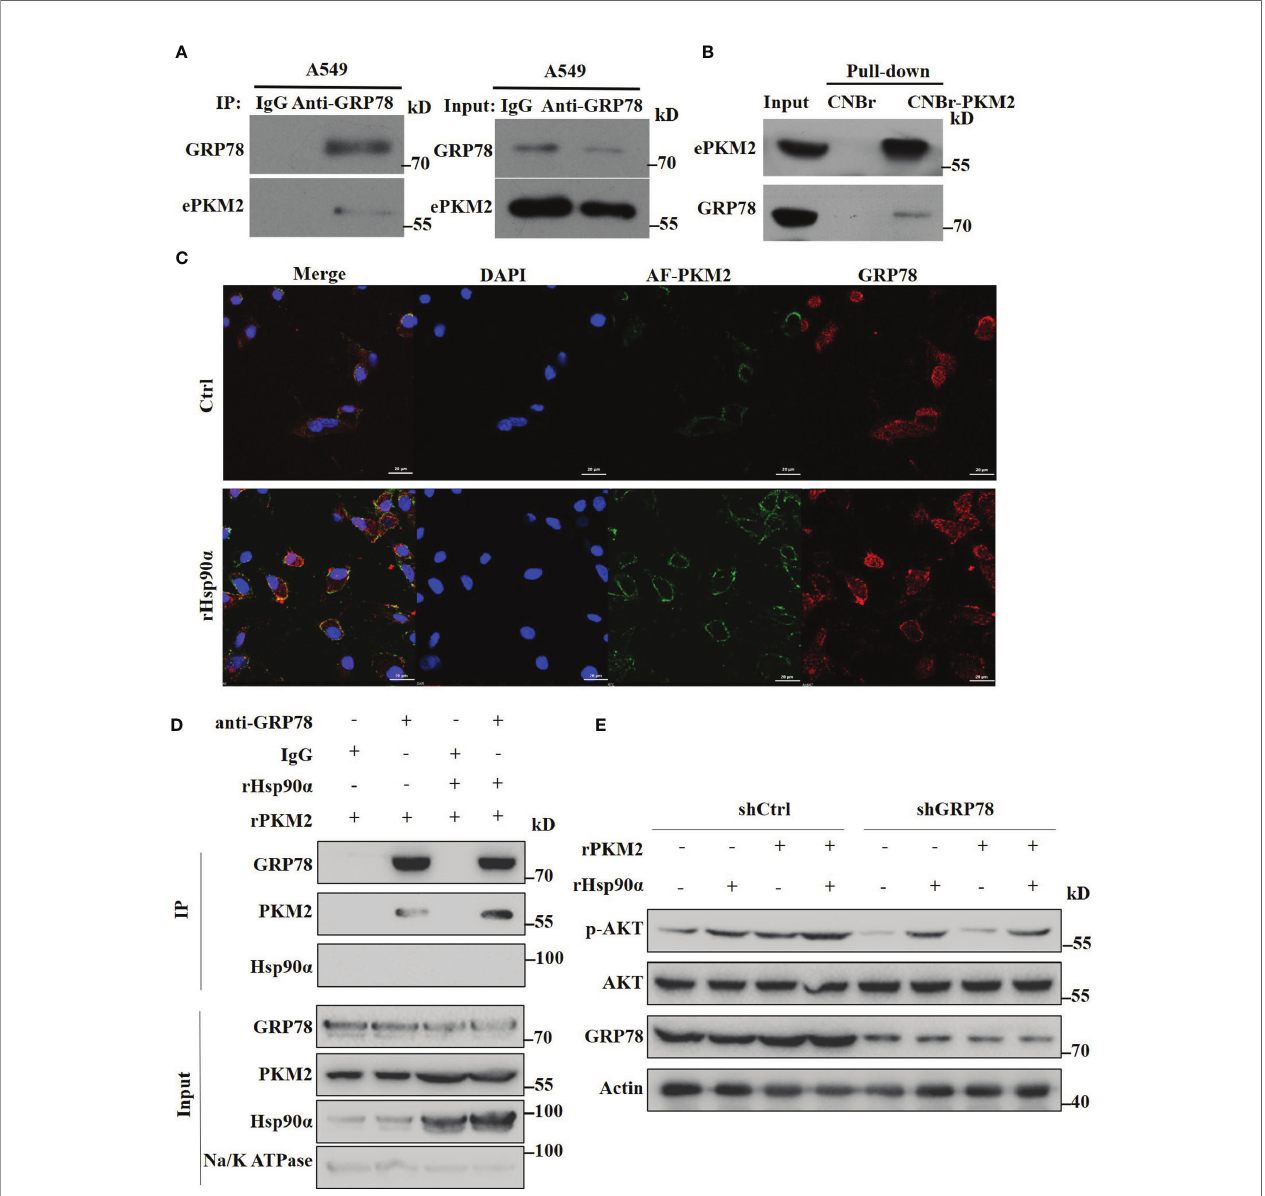
FIGURE 6 | Extracellular Hsp90 a boosts the ePKM2-GRP78-AKT pathway. (A) A549-conditioned media was collected and immunoprecipitated with IgG or anti-GRP78 antibodies. The immunoprecipitated samples were subjected to WB analysis with the indicated antibodies to detect the interaction between PKM2 and GRP78. (B) Pull- down assay showing the interaction between PKM2 and cell surface GRP78. Recombinant PKM2 was coupled to cyanogen bromide-activated Sepharose beads and was incubated with crude fractions of the plasma membrane of A549 cells. (C) Co-localization between rPKM2 labeled with Alexa Fluor 488 (AF-PKM2) and GRP78 in A549 cells treated with or without rHsp90 a . Scale bar, 20 m m. (D) rHsp90 a enhances the interaction between rPKM2 and cell surface GRP78. Crude fractions of the plasma membrane of A549 cells were extracted and immunoprecipitated with IgG or anti-GRP78 antibodies treated with rPKM2 and rHsp90 a . (E) A549-sh Ctrl and A549-sh GRP78 cells were treated with rPKM2 (5 m g/ml), rHsp90 a (5 m g/ml), or the combination of Hsp90 a and PKM2 for 15 min. Akt phosphorylation levels were detected by western